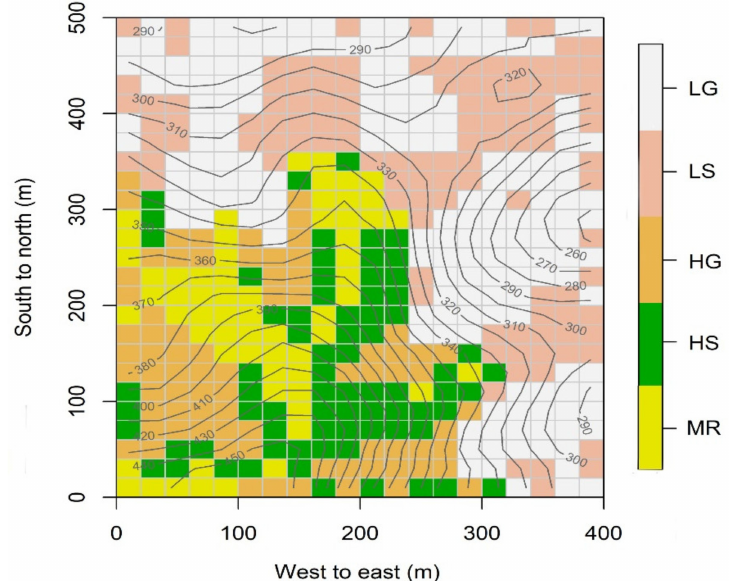
Figure 1. The spatial distribution of the five habitat types (LG, low gully; LS, low slope; HG, high gully; HS, high slope and MR, mountain ridge) with 20 m × 20 m grid cell in the 20-ha DHS plot,